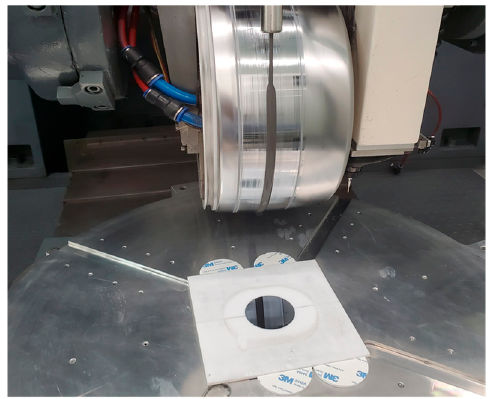
Figure 12. Experimental photo of magnetorheological polishing.